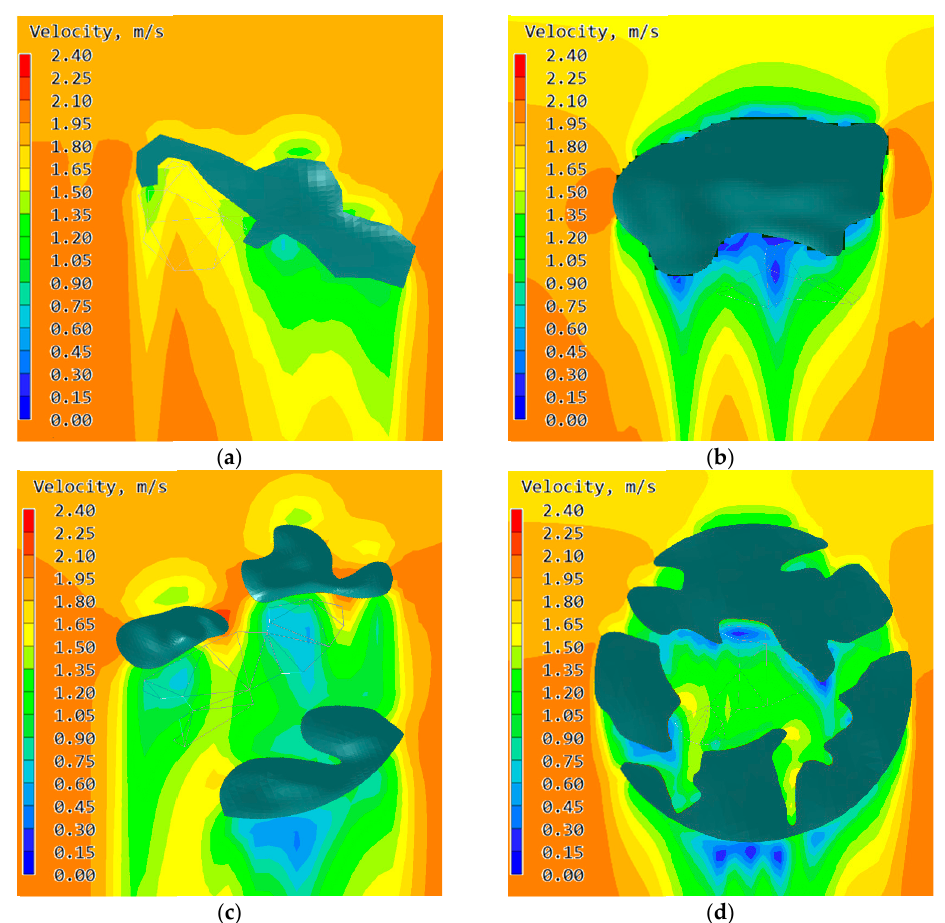
Figure 9. ( a ) Winter wind speed simulation in Xiasong village; ( b ) Winter wind speed simulation in Rongfang village; ( c ) Winter wind speed simulation in Zhuqiao village; ( d ) Winter wind speed simulation in Xuyuan village.